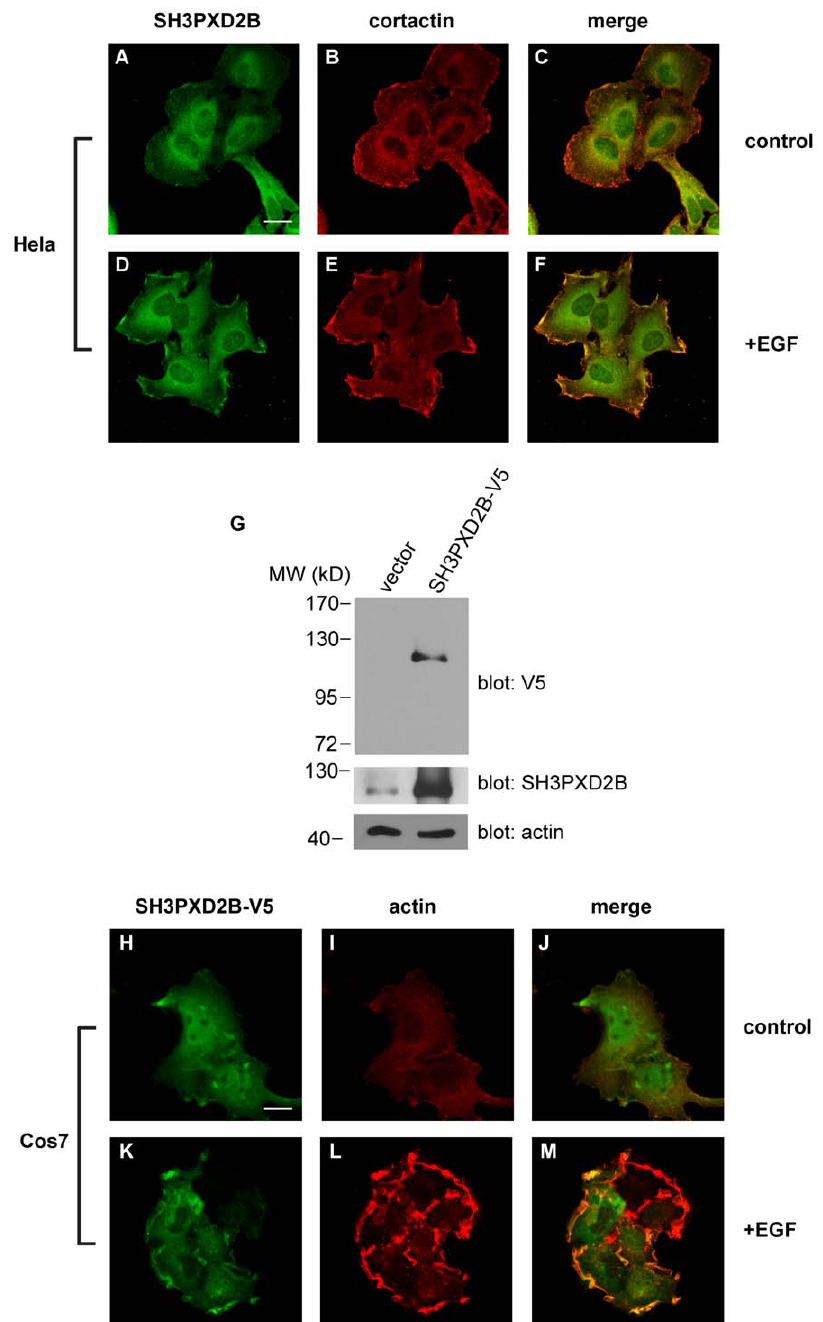
Figure 2. Epidermal growth factor receptor activation induces the co-localization of SH3PXD2B with cortactin and F-actin in membrane ruffles and lamellipodia. Serum starved cells were left untreated ( A–C and H–J ) or treated with 100 ng/ml EGF ( D–F & K–M ) for 10 minutes. Cells were then fixed and processed for immunofluorescence. Endogenous expression of SH3PXD2B and cortactin in HeLa cells ( A–F ) were detected using SH3PXD2B-specific rabbit polyclonal or cortactin-specific mouse monoclonal antibodies. Cellular localization of SH3PXD2B in Cos7 cells transfected with a construct encoding an SH3PXD2B fusion protein carrying a C-terminal V5 epitope tag ( H–M ) was visualized using a mouse anti-V5 monoclonal antibody and anti-mouse Alexa488 (green). Filamentous actin (F-actin) was stained with Alexa568-labeled phalloidin. Bars indicate 20 m m. Efficiency of SH3PXD2B-V5 overexpression was analyzed by western blotting (G). doi:10.1371/journal.pone.0023653.g002 stripping and re-probing the anti-pY blots with the corresponding specific antibodies (not shown).